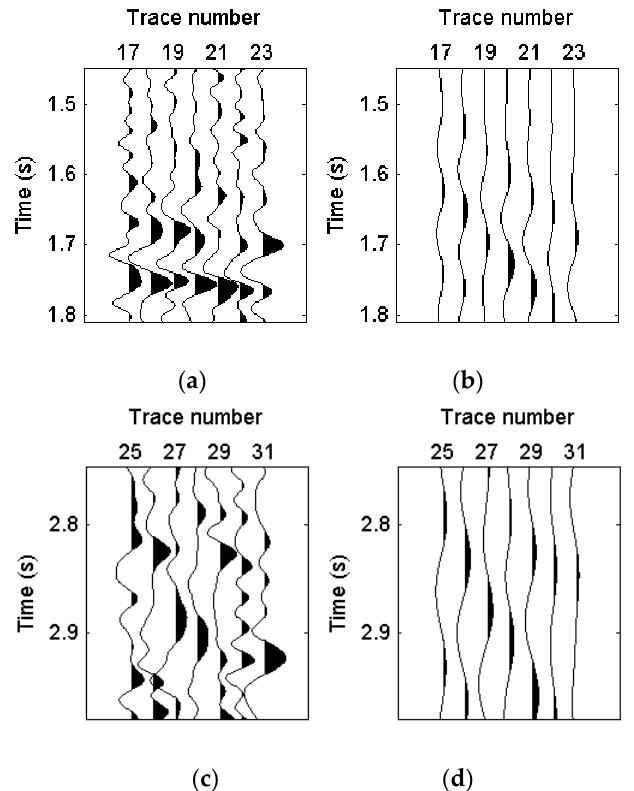
Figure 12. Details of waveforms of ( a ) section A in Figure 9, ( b ) section A in Figure 11a, ( c ) section B in Figure 9, and ( d ) section B in Figure 11a.